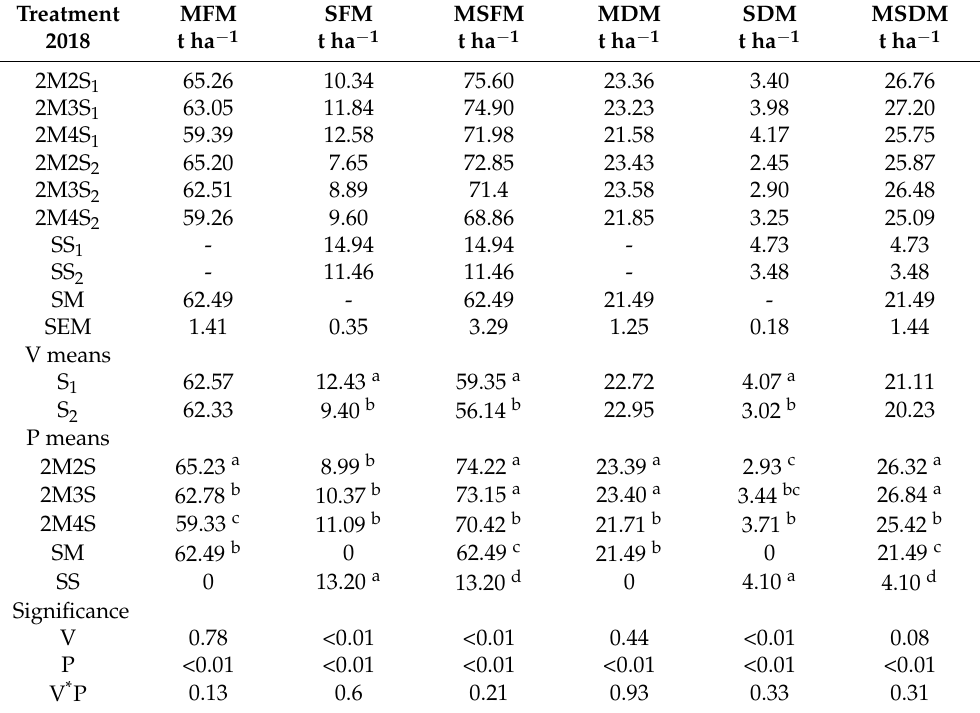
Table 1. Whole crop fresh and dry matter yield of maize and soybean as affected by different planting patterns during